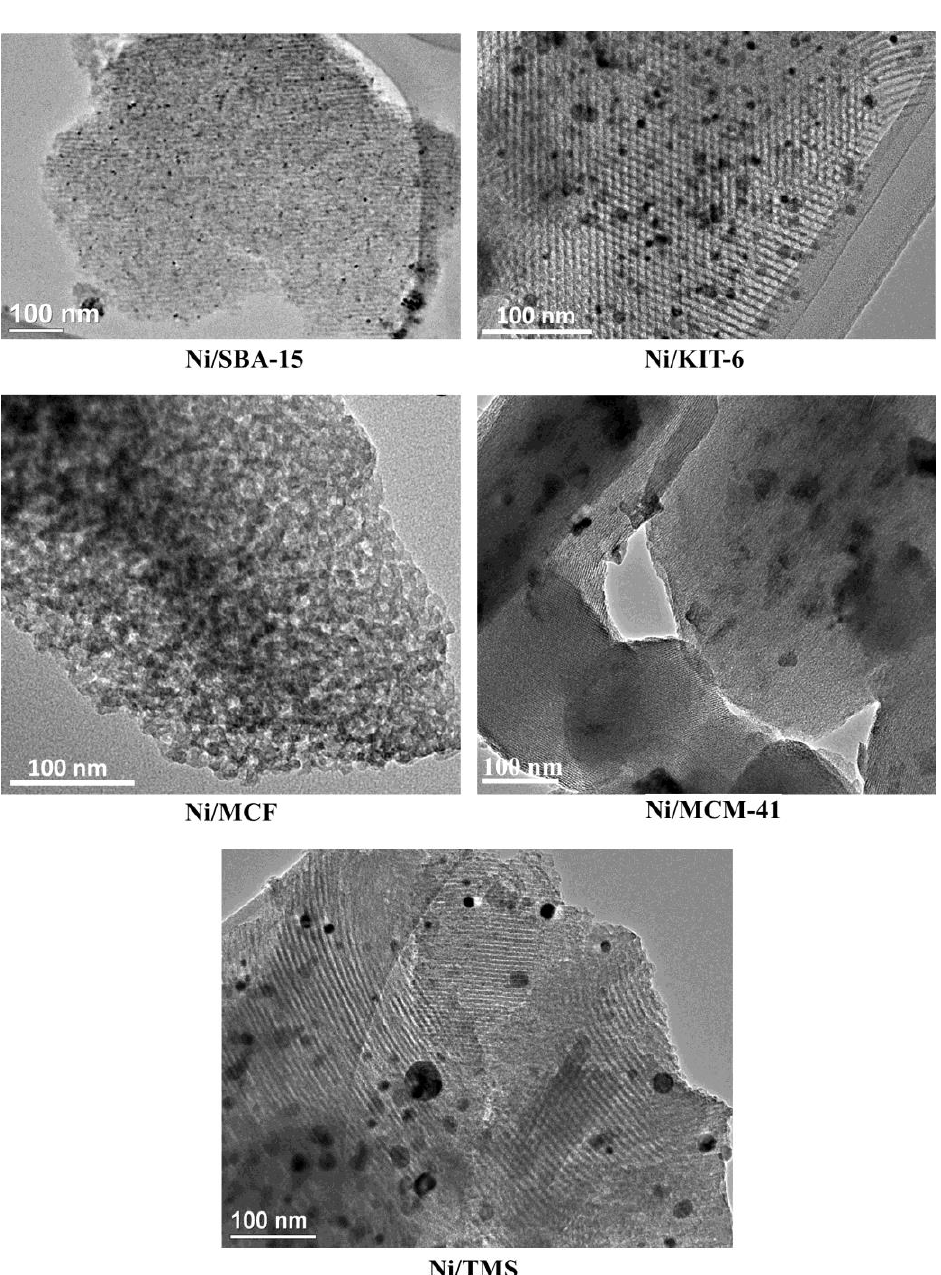
Figure 8. TEM images of the Ni/SiO 2 catalysts.